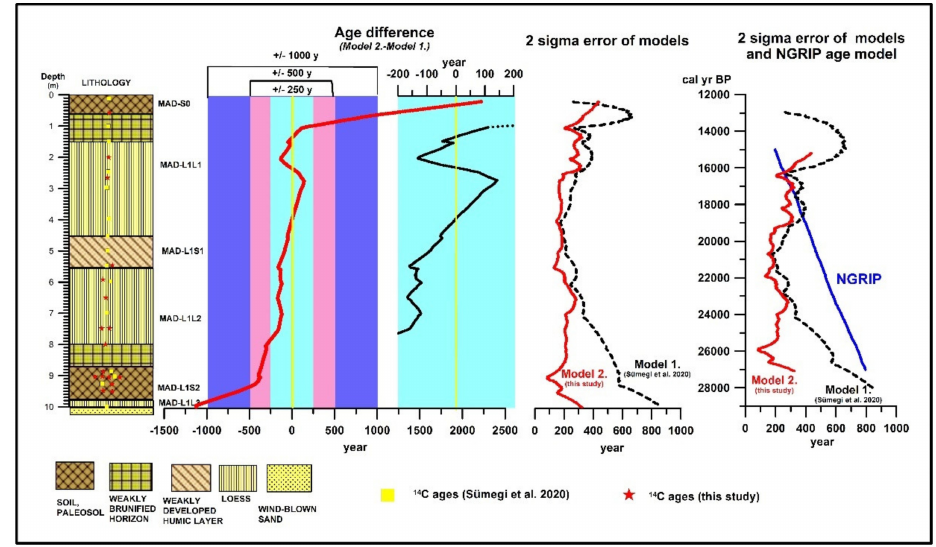
Figure 4. Observed differences in mean ages as well as 2-sigma uncertainties of Model 1 and 2 as well as uncertainty of the NGRIP age model ( 14 C ages from